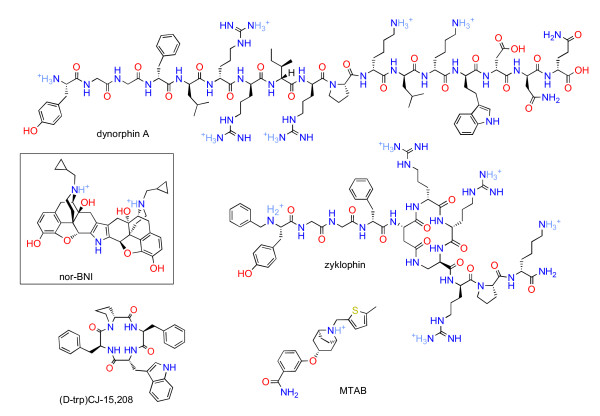
Structures of nor-BNI, short-acting κ antagonists and dynorphin A, to the same scale.